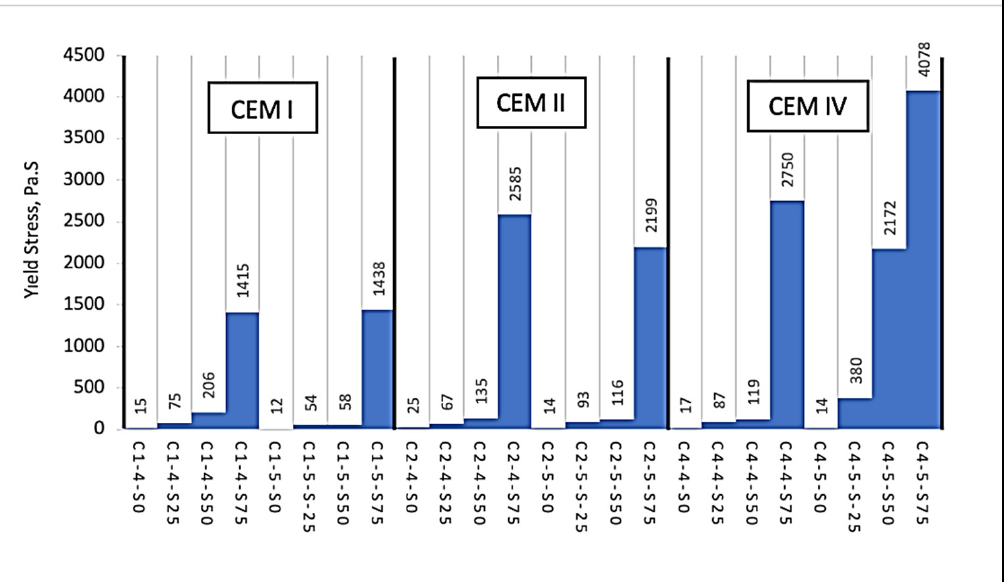
Figure 9. Yield stress values of SAPCPs, including di ff erent cement types and SAP contents.